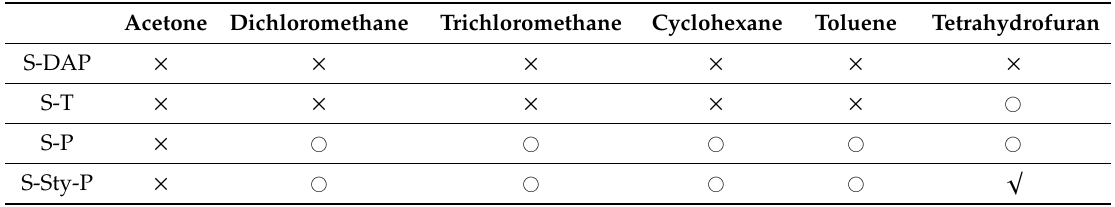
Table 1. The solubility of serial disulfide polymer in different solvents.